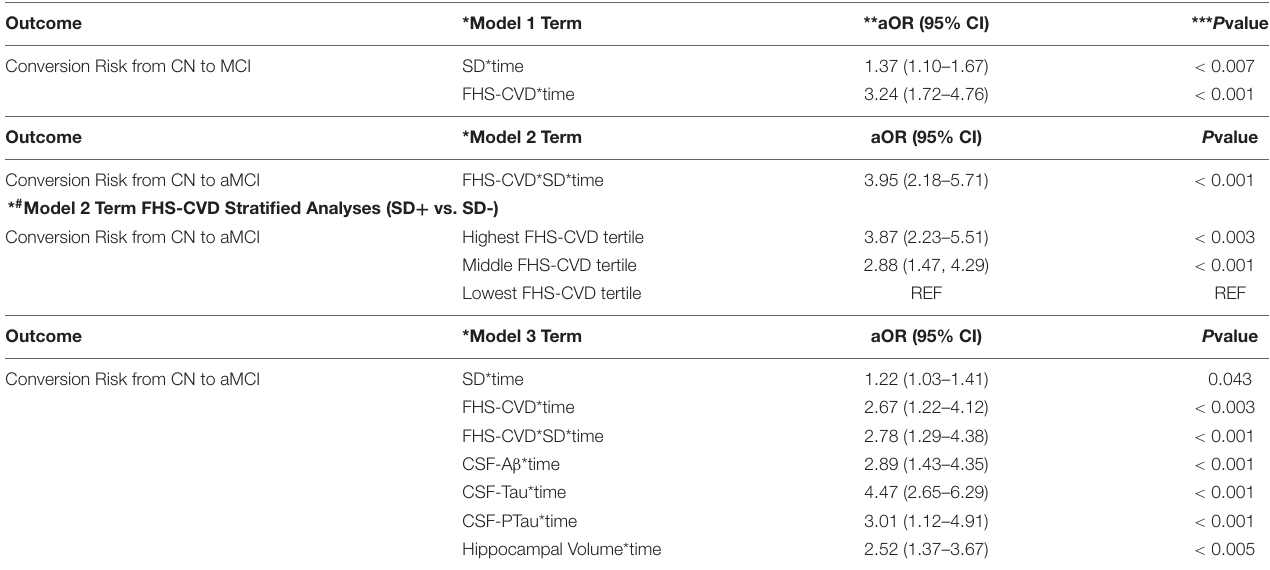
TABLE 5 | Interactive associations of NPI-Q assessed sleep disturbance (SD) and vascular risk with an MCI (aMCI + non-amnestic MCI) diagnosis during follow-up in clinically normal older adults, NACC UDS data. Outcome *Model 1